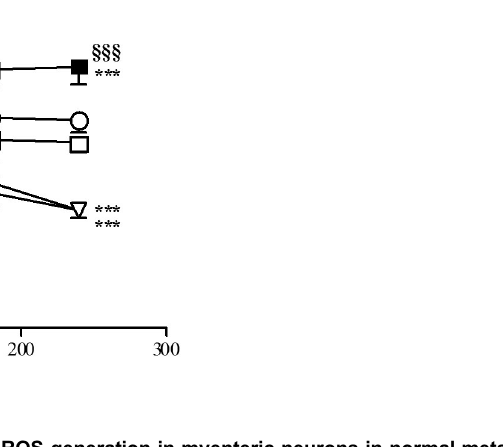
Figure 6. Effect of -AP5 and CNQX on ROS generation in myenteric neurons in normal metabolic conditions. Graphs indicate the extent and timescale of free radical generation (GV 5 mean grey value of HPF fluorescence intensity) in enteric neurons, with -AP5 100 m M ( % ) and 500 m M ( & ); CNQX 100 m M ( , ) and 500 m M ( . ); and in control untreated preparations ( # ). Each point represents the mean of at least 3 experiments. Vertical bars indicate S.E.M. *** P , 0.001 with respect to normal metabolic conditions without drug treatment; 111 P , 0.001 with respect to -AP5 100 m M by two-way ANOVA.